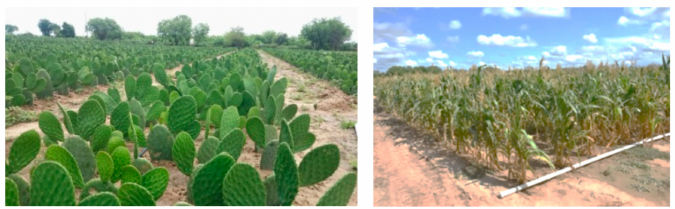
Figure 6. The plot of organic agricultural soil with nopal and corn production.